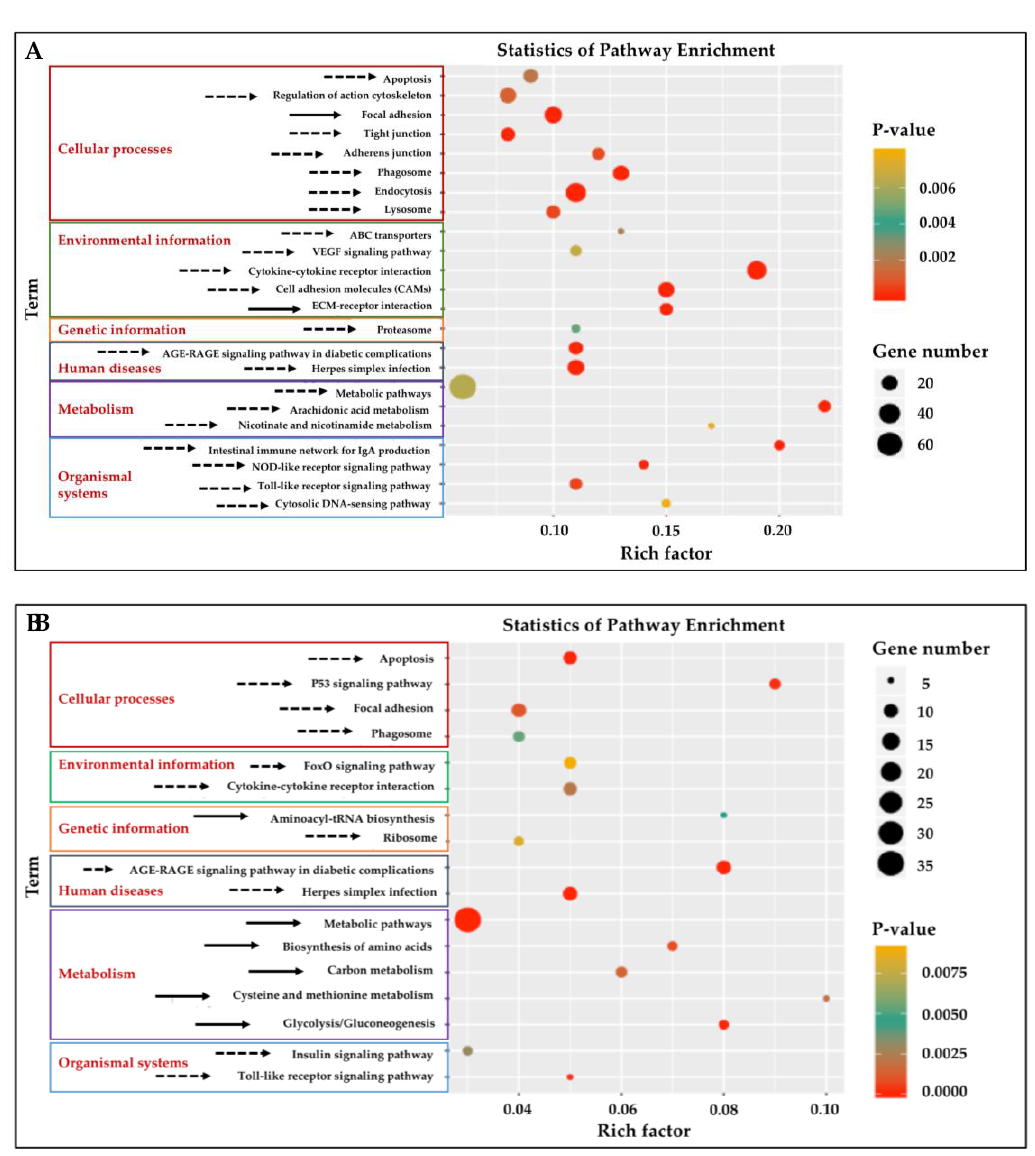
Figure 3. Kyoto Encyclopedia of Genes and Genomes (KEGG) pathway analysis of enrichment of the DEGs from the gill and adipose fin. ( A ) Twenty-three KEGG pathways were enriched ( p < 0.01) in the gill tissues by comparing the HT and NT groups. ( B ) Seventeen KEGG pathways were enriched ( p < 0.01) in adipose fin tissues. Rich factor is the ratio of the number of DEGs to the total number of genes in a certain pathway. The size and color of the dots represent the number of genes and the range of the p values, respectively. Solid arrows indicate up-regulated pathways, and dotted arrows indicate down-regulated pathways.